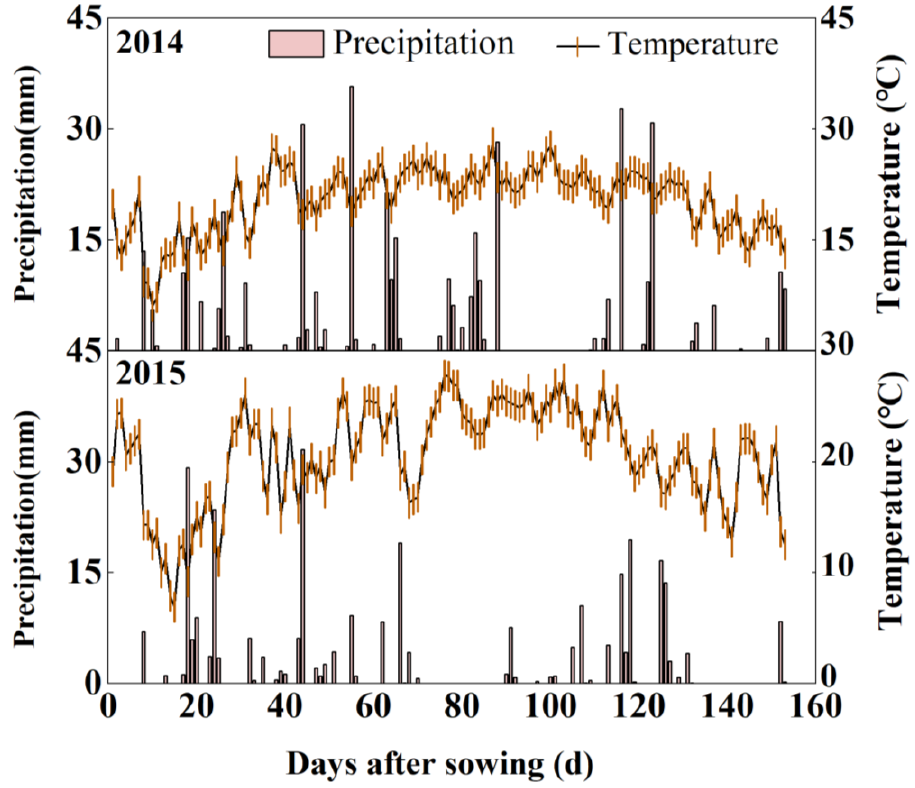
Figure 1. Daily precipitation and mean temperature during the growing seasons of 2014 and 2015.